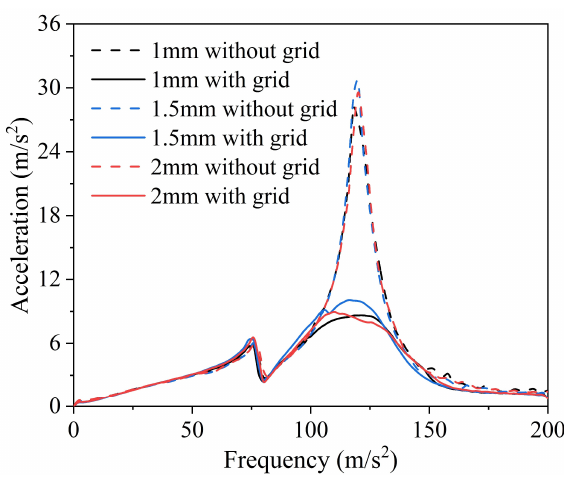
Figure 5. Different particle size samples.